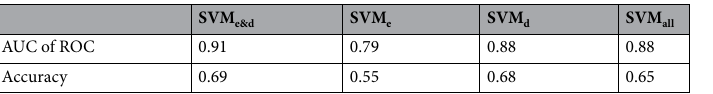
Table 1. Assessment of SVM classification when the classifiers were trained with an outlier ratio of 8%.